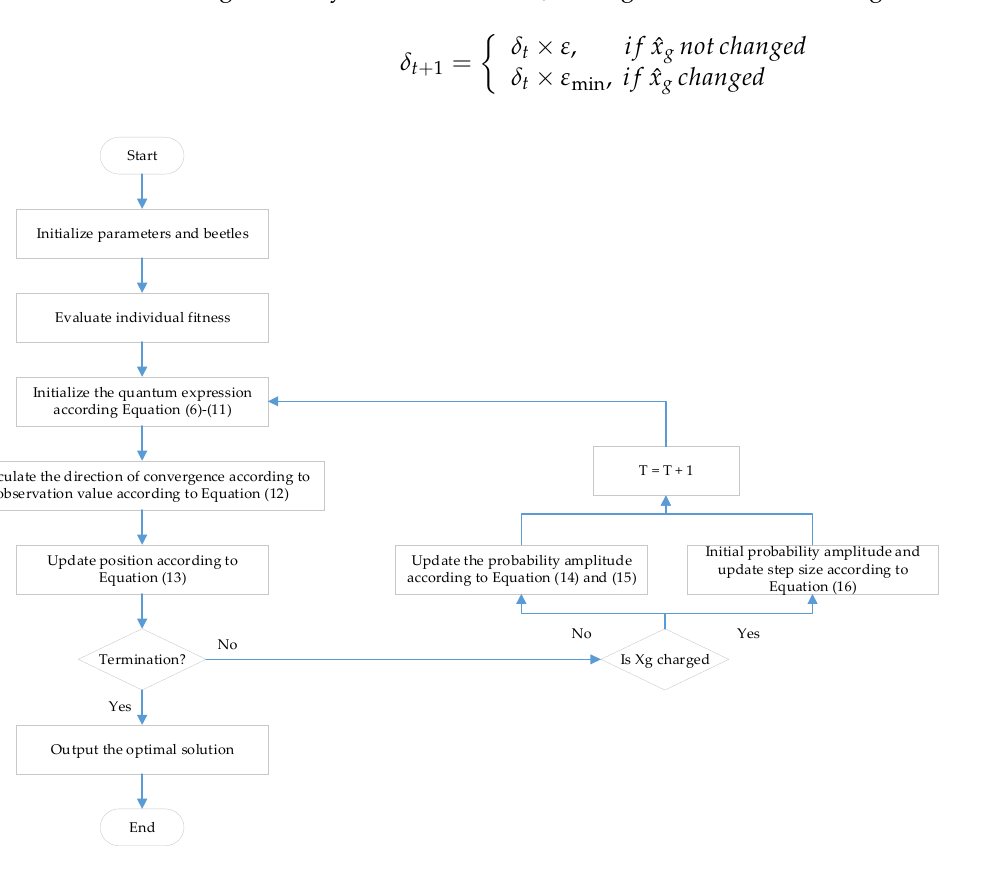
Figure 3. Procedure of the QBSO algorithm.